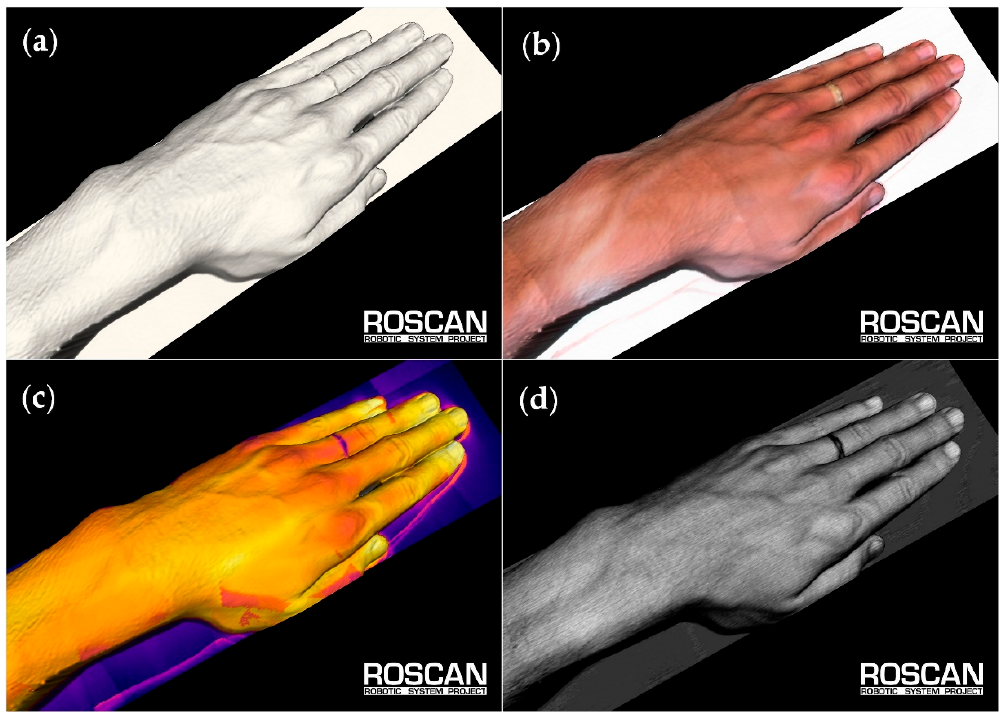
Figure 6. The output model of the RoScan system consists of several layers: ( a ) a 3D spatial representation without coloring; ( b ) a surface with true colors; ( c ) false-color-mapped thermal data; ( d ) false-color-mapped roughness data.